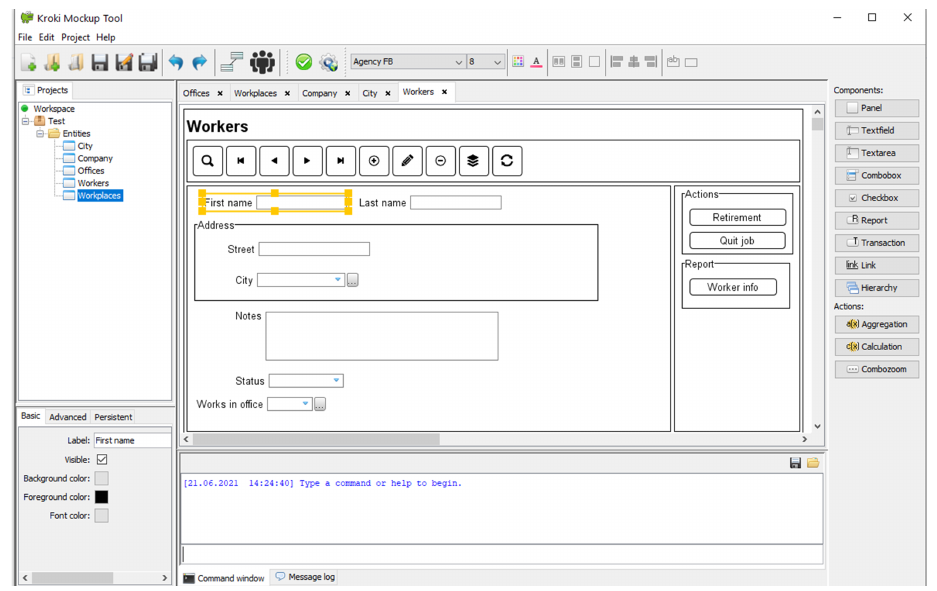
Figure 1. Kroki Mockup editor.